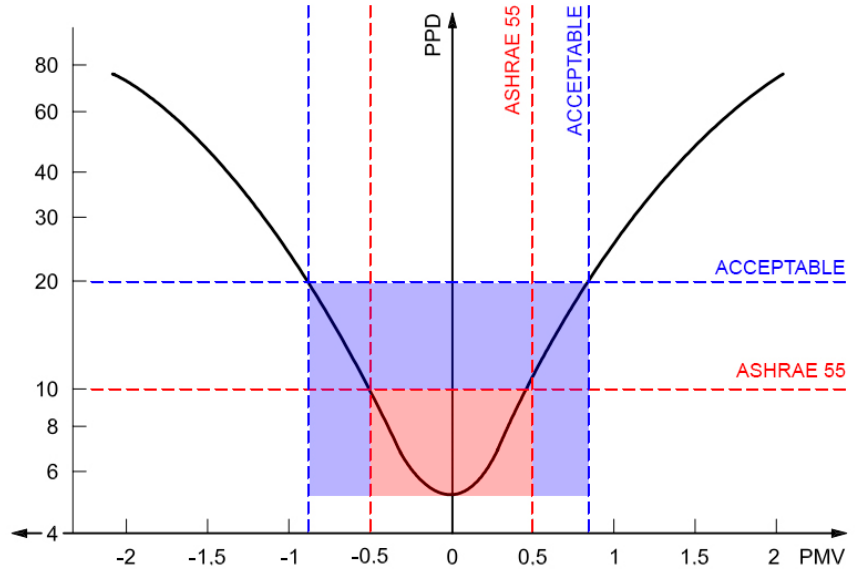
Figure 6. PMV—Fanger thermal comfort models. Source: Redrawn by the first author. Mean Radiant Temperature (MRT)